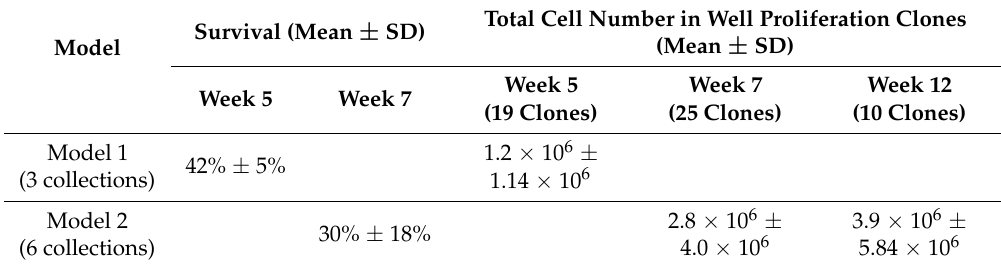
Table 1. Survival rates and expansion levels of NK cell clones obtained in model 1 and model 2. Total cell numbers were counted in randomly selected well proliferating clones.